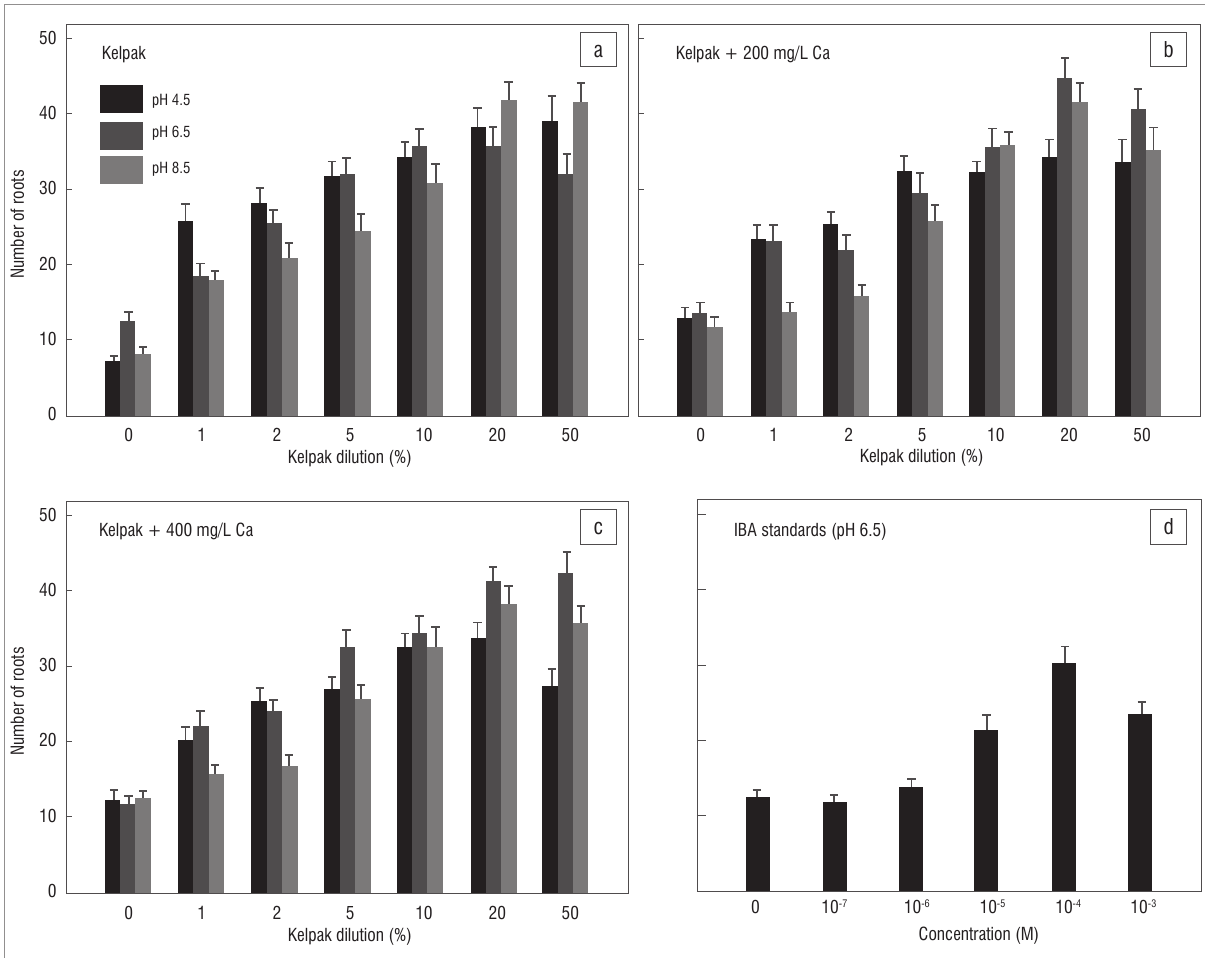
Figure 2: Effect of pH and water hardness (Ca 2+ concentration) on the root-promoting ability of the seaweed concentrate Kelpak at 0–50% in the mungbean rooting bioassay (mean±SE; n =40). Specific values for the various treatments with Kelpak ® at 0%, 2% and 20% are given in Table